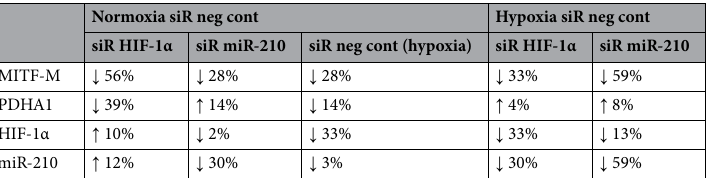
Table 1. Comparison of the relative expression values to siR neg cont in normoxia for siR HIF-1α and siR miR-210 and comparison of the relative expression values to siR neg cont in hypoxia for siR HIF-1α and siR miR-210 in